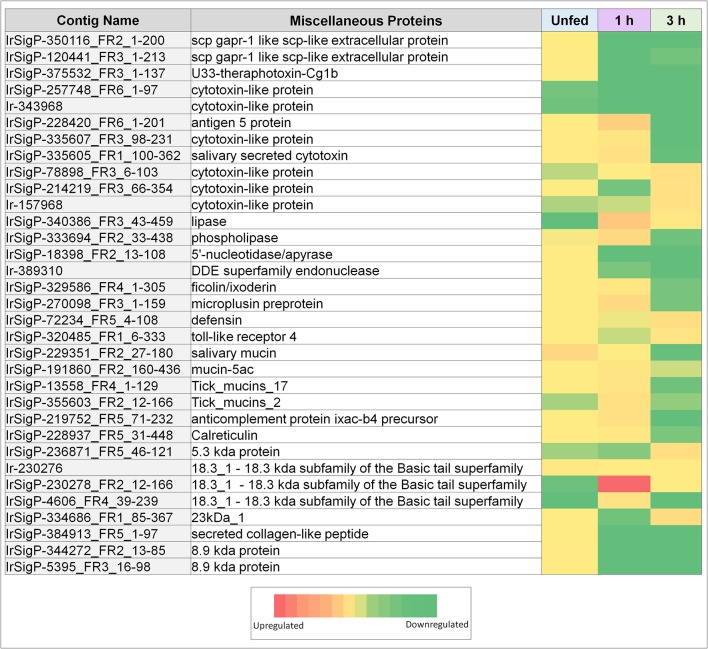
Heatmaps of several categories of genes identified in salivary glands of Ixodes ricinus ticks as up or down regulated in response to TBEV infection, including miscellaneous genes (cytotoxins, anti-microbial genes, and mucins). Regulation is generally most influenced at a single timepoint, often as the inverse of the pattern seen in other timepoints. Expression in each category is also not consistent between proteins, indicating that expression of each individual gene is not equivalent, and under complex regulatory control.